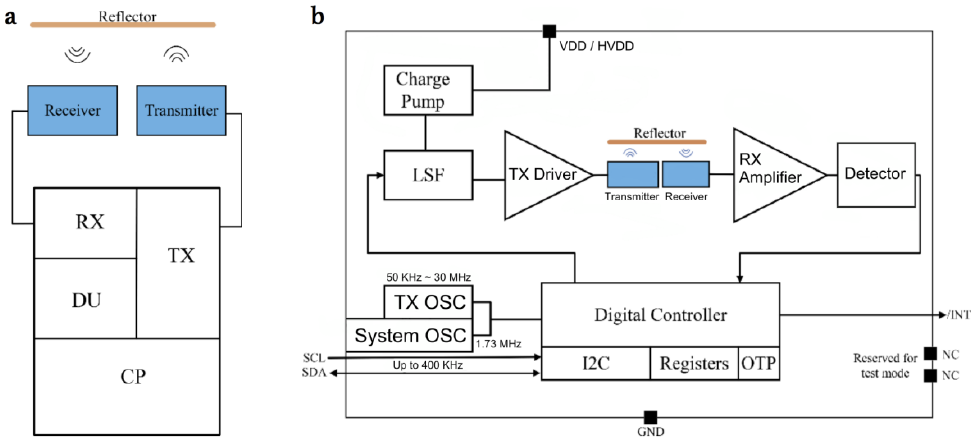
Figure 1. The block diagram of ultrasonic time of flight (TOF) ranging system using aluminum nitride (AlN) piezoelectric micromachined ultrasonic transducers (PMUTs). ( a ) One PMUT is a transmitter and the other is a receiver. ( b ) The function block diagram of the system.